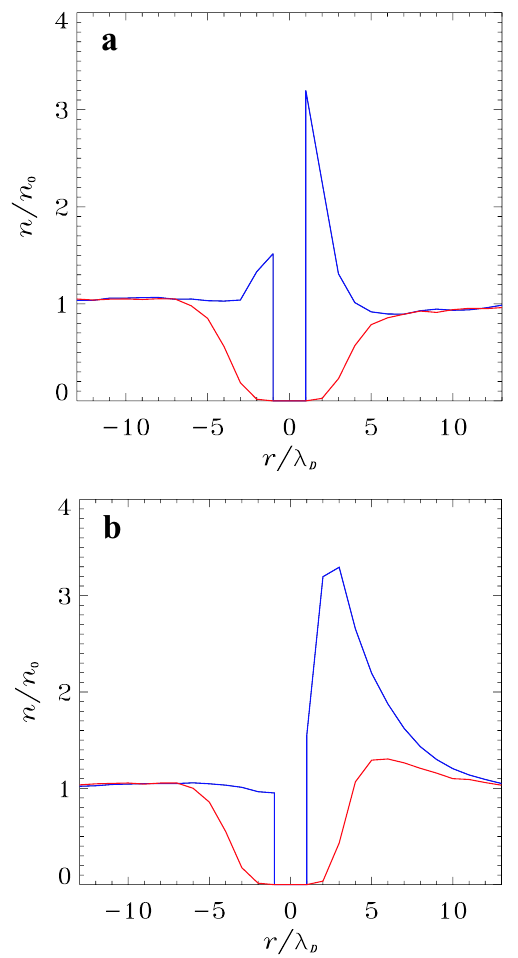
Fig. 10. Positive (blue) and negative (red) charge densities along the x − axis parallel to the flow velocity for ϕ =− 20 kT/e (a) in an H + plasma with V 0 = V Ti and (b) in an O + plasma with V 0 = 4 V Ti . Plasma and probe parameters are the same as in Fig. 2. Charges are normalised by their values in the undisturbed plasma, distances by the Debye length.